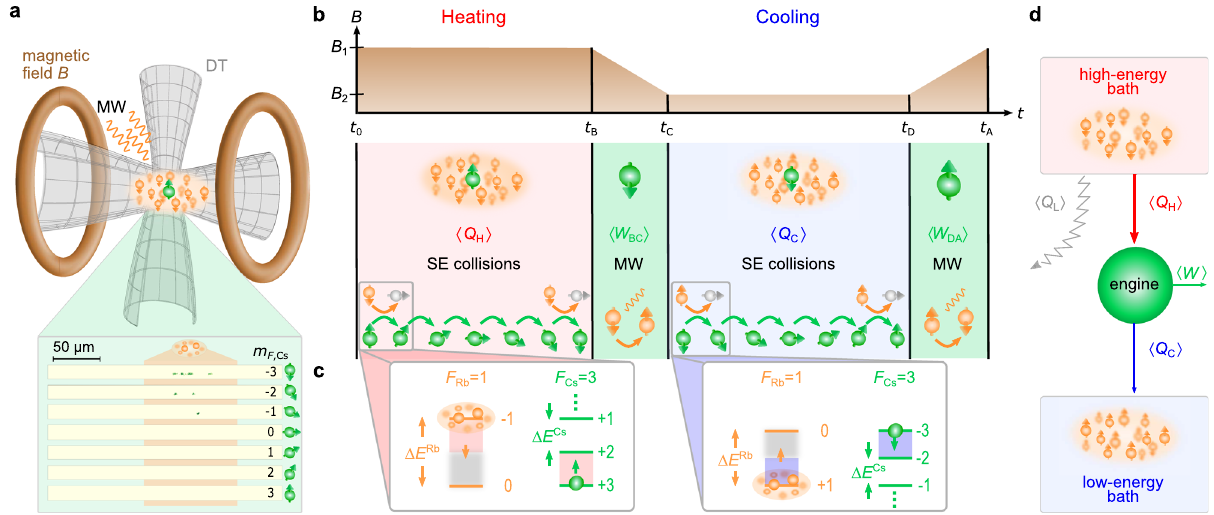
Fig. 1 Operation principle of the quantum heat engine. a Individual laser-cooled Cs atoms (green) are immersed in an ultracold Rb cloud (orange); both are con fi ned in a common optical dipole trap (DT). External magnetic fi elds and microwave (MW) radiation, respectively, implement the power strokes of the quantum heat engine and distinguish the high- from the low-energy bath. The inset shows typical m F -resolved fl uorescence images of single Cs atoms for t = t B = 300 ms after initialization, from which the quantized spin, and thus heat exchange, can be determined. The position of the bath cloud is indicated in orange with a width of 4 σ . b The experimental Otto cycle consists of a heating stage, during which average heat 〈 Q H 〉 is absorbed, and a power stroke induced by an adiabatic change of the magnetic fi eld. A microwave fi eld then switches the bath from high to low energy. The cycle is further completed by a cooling step, during which average heat 〈 Q C 〉 is released, and an additional power stroke when the magnetic fi eld is adiabatically brought back to its initial value. c The heat transfer between the Cs atom (engine) and a Rb (bath) atom occurs via inelastic spin-exchange collisions. In each collision, a single quantum of spin associated with a certain energy quantum is exchanged. Spin polarization of the Rb atoms and spin-conservation in individual collisions allow only up to six exo- or endothermal processes, corresponding to heating or cooling. d Owing to the difference of atomic Landé factors between Cs and Rb, the quantum heat engine (green) absorbs heat 〈 Q H 〉 and releases heat 〈 Q C 〉 (to produce work 〈 W 〉 ), while the bath releases more energy. The lost energy is irreversibly dissipated during an average of ten elastic collisions and is described by a heat leak 〈 Q L 〉 from the high- energy (cid:1) (cid:3) λ B for cooling. On the other 2